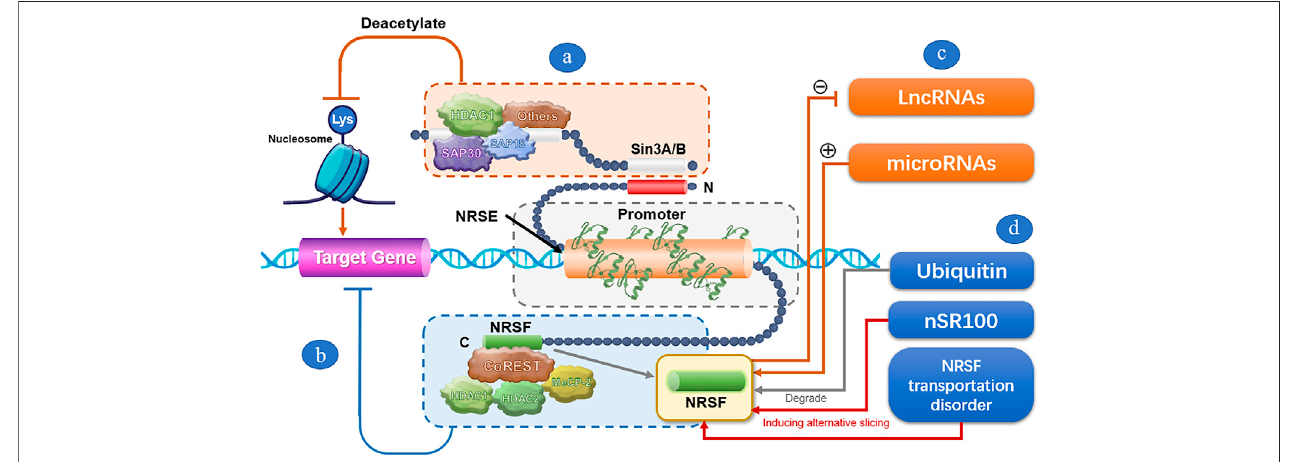
FIGURE1| AschematicillustrationofthetranscriptionalrepressionmechanismbyNRSF. (A) Afterspeci fi callybindingofNRSFtotheNRSEsequenceofthetarget gene, the N-terminal repression domain of NRSF can bind to mSin3A/B, and recruit HDACs and other factors to form transcriptional inhibition complex. The complex deacetylates lysine residues of nucleosome histones, prompting tight nucleosome encapsulation to form heterochromatin that blocks the transcription of target genes and thus maintainsgenesilencing. (B) TheC-terminalrepression domain canbindtoREST co-repressor proteins (CoRESTs), and further attract HDAC1,HDAC2, andMeCP2topromoteandmaintainmethylatedCPG-dependentgenesilencing. (C) LncRNAsandmicroRNAsregulatetheexpressionofNRSFthroughtheregulatory feedback mechanism. (D) Ubiquitin dynamically modulates NRSF expression by degrading NRSF through ubiquitin-mediated proteolysis. nSR100 negatively regulate NRSF by inducing alternative slicing of NRSF. NRSF transportation disorder reduces the NRSF level in the nucleus, thus alleviating the transcriptional repression by NRSF.